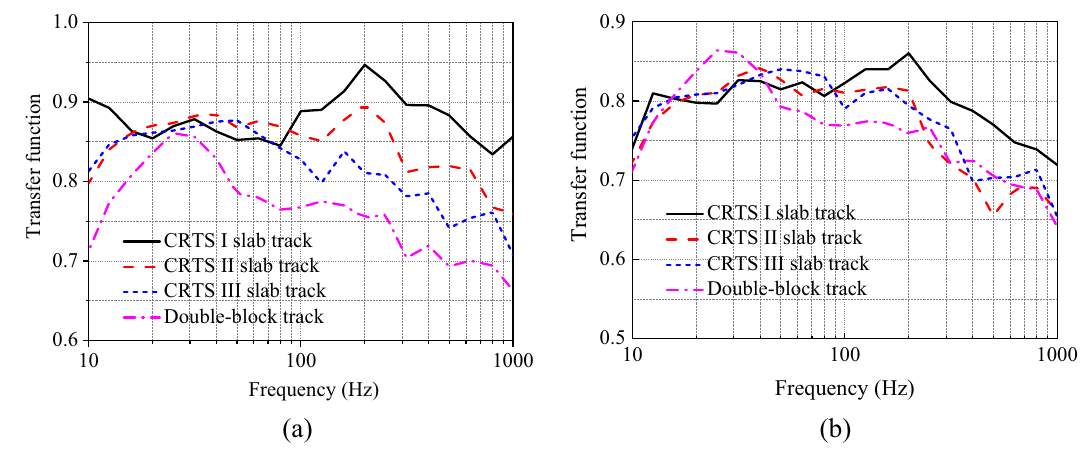
Fig. 17 Transfer functions of vibration in different ballastless track structures used in high-speed railways: a from the rail to the slab; b from the rail to the concrete base